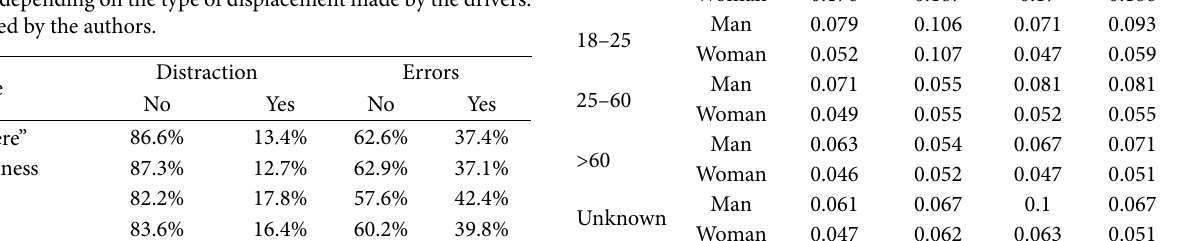
Table 3: Probabilities of distracting or making mistakes during driving depending on the type of displacement made by the drivers. Processed by the authors.